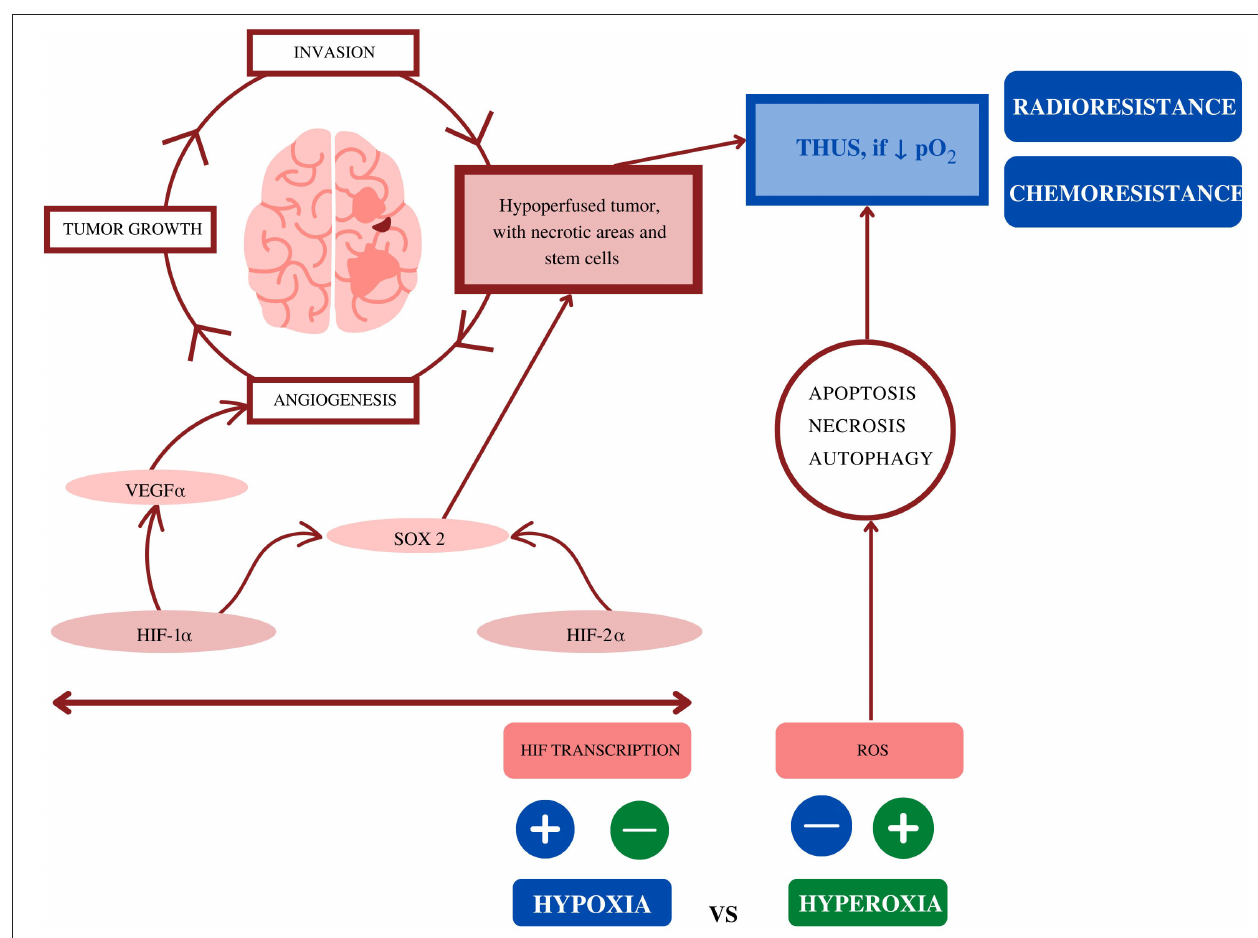
FIGURE 2 | Overview of the influence of hypoxia on glioblastoma: Oxygen deficiency is the main contributor to both chemo- and radioresistance (made with Canva ® 2022, under a Pro license). HIF, hypoxia-inducible factors; HIF-1 α , hypoxia-inducible factor 1 α ; HIF-2 α , hypoxia-inducible factor 2 α ; pO 2 , partial pressure of oxygen; ROS, reactive oxygen species; SOX2, sex-determining region Y-box